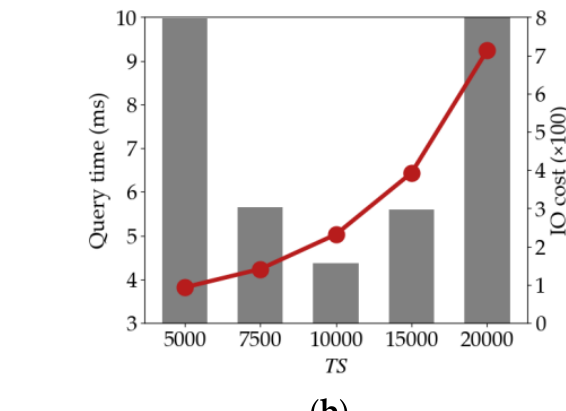
( b ) Figure 5. Build performance vs. data distribution. ( a ) Index structure size. ( b ) Build time.